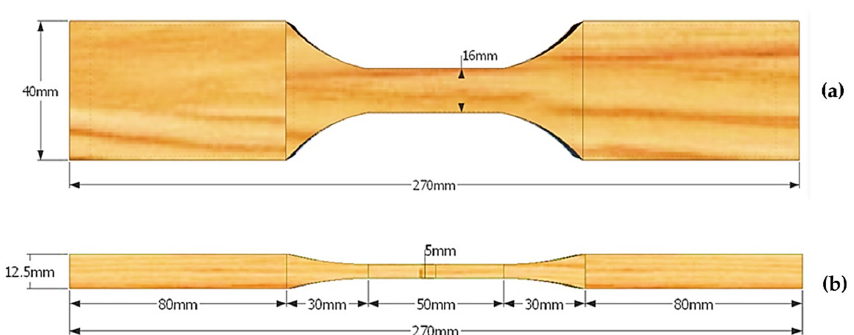
Figure 5. Shape and dimensions of the specimen for tension parallel to grain test. Top ( a ) and side ( b ) views.